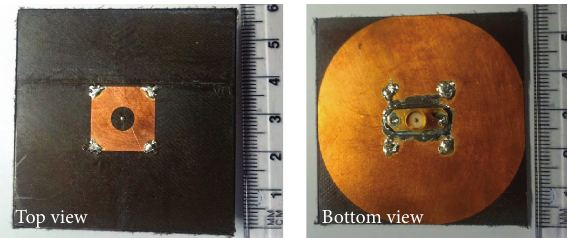
Figure 8: Manufactured prototype based on Rogers Duroid 5880 substrate.